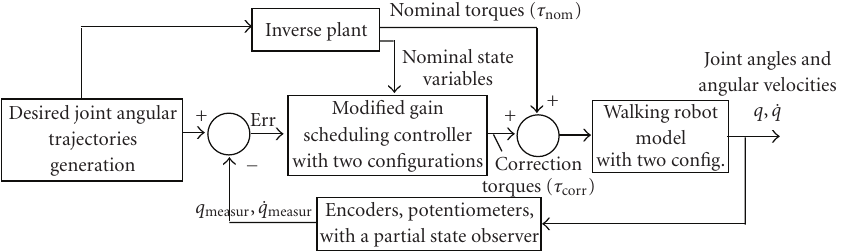
Figure 13: The nonlinear system control based on a gain scheduling approach and the inverse plant prediction. The controller switches between two configurations corresponding to the single support and the double support phase.